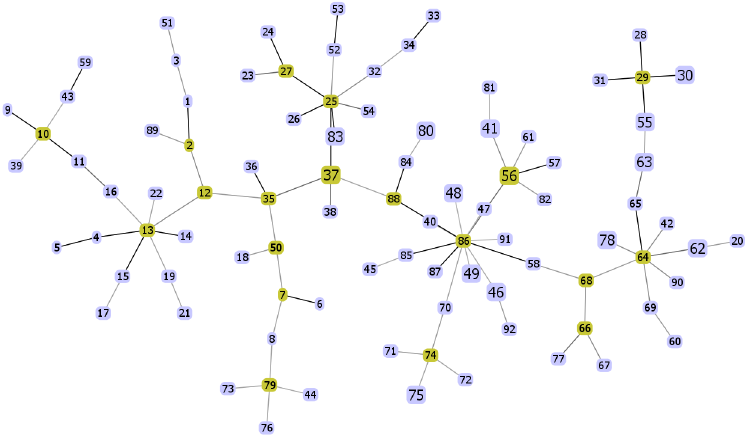
Fig 3. Clonal complex of O . tsutsugamushi population from Laos and Thailand (163 isolates) using global optimal eBURST (goeBURST) with full minimum spanning tree (MST). ST node colors are followed; green — group founder and light blue — common